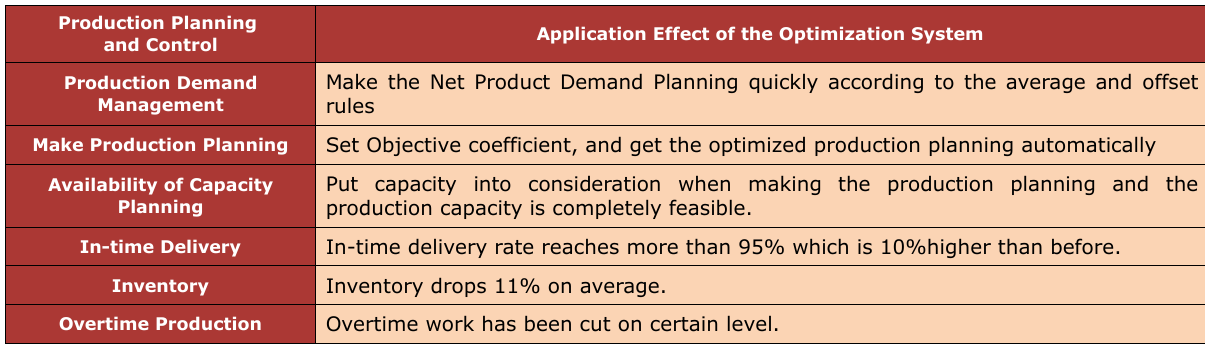
Table 4. Application